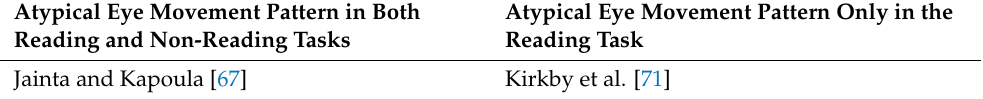
Table 3. Summary of studies that used both reading and non-reading tasks in order to study eye movement patterns of